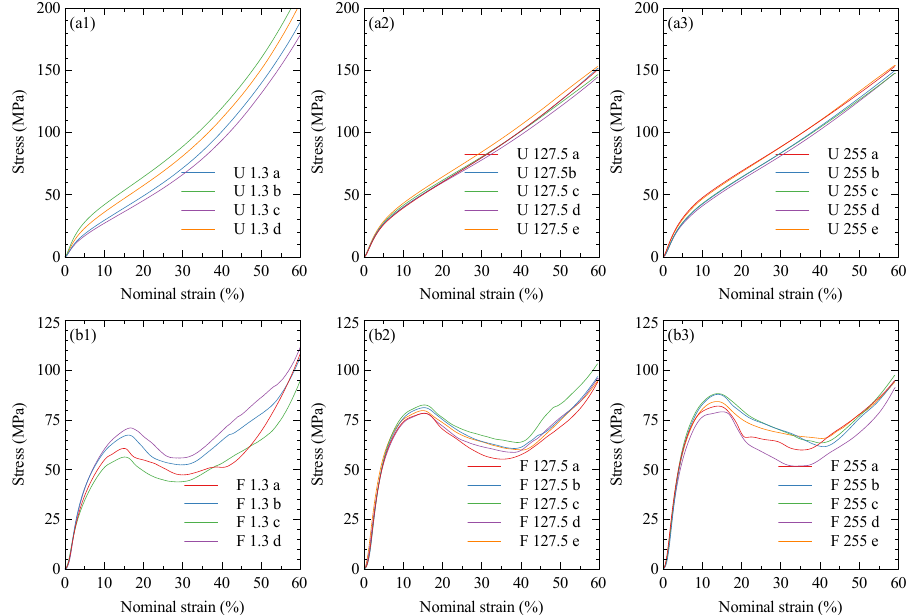
Figure 8. Onyx compressive stress–strain curves. Infill geometry is denoted by ( a ) upright, and ( b ) flat. Compressive speed denoted by ( 1 ) 1.3 mm/min, ( 2 ) 127.5 mm/min, and ( 3 ) 255 mm/min.